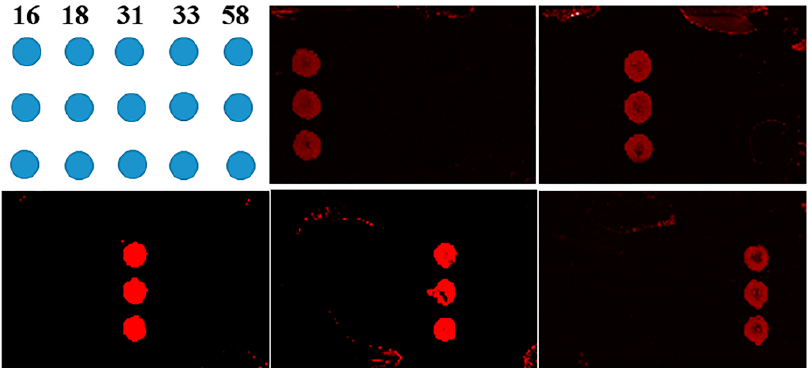
Figure 5. The specificity of the integrated chip for the genotyping of HPV16, 18, 31, 33, and 58.